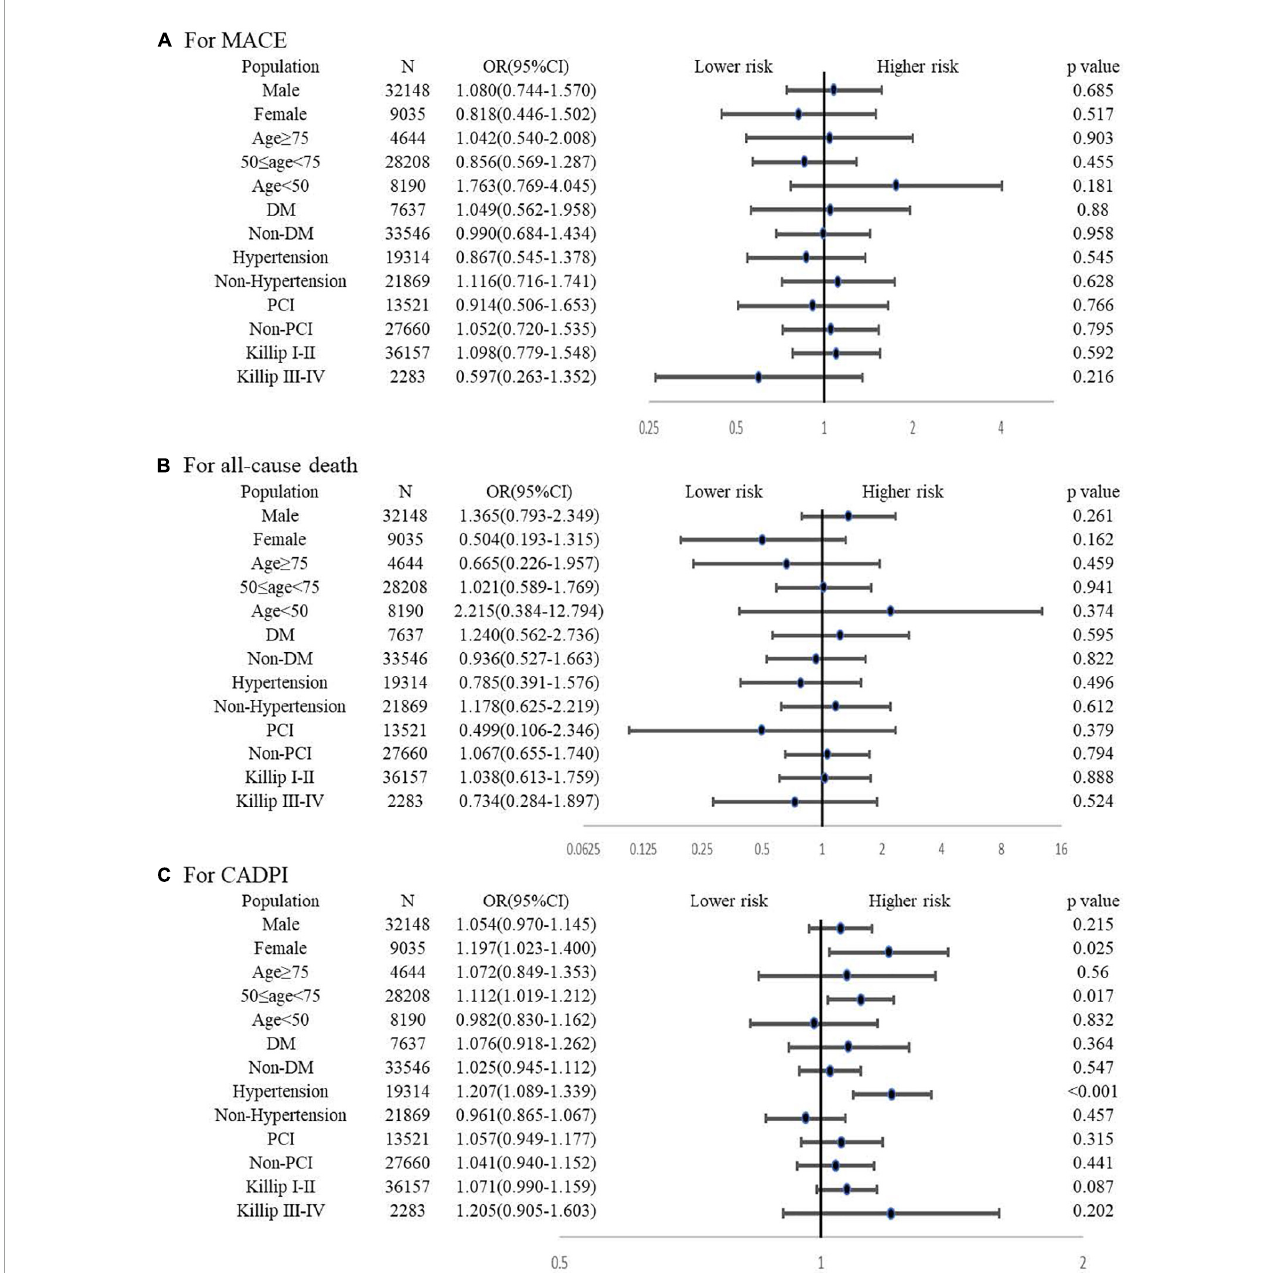
FIGURE2 Subgroup analysis for the association between pre-hospital statin treatment and in-hospital outcomes or severely obstructive CAD (CADPI ≥ 37). (A) Association between pre-hospital statin treatment and in-hospital MACE. (B) Association between pre-hospital statin treatment and in-hospital all-cause death. (C) Association between pre-hospital statin treatment and severely obstructive CAD (CADPI ≥ 37). DM, diabetes mellitus; PCI, percutaneous coronary intervention; CADPI, coronary artery disease prognostic index ; MACE, major adverse cardiovascular event. A value of P < 0.05 was considered statistically significant. Adjusted variables for MACE finally included age, sex, current smoking, early family history of CAD, hypertension, DM, ACS type, Killip class, HR, severe clinical conditions at admission (cardiac shock, cardiac arrest and HF), pre-hospital medicine ( β -blockers, ACEI, ARB and